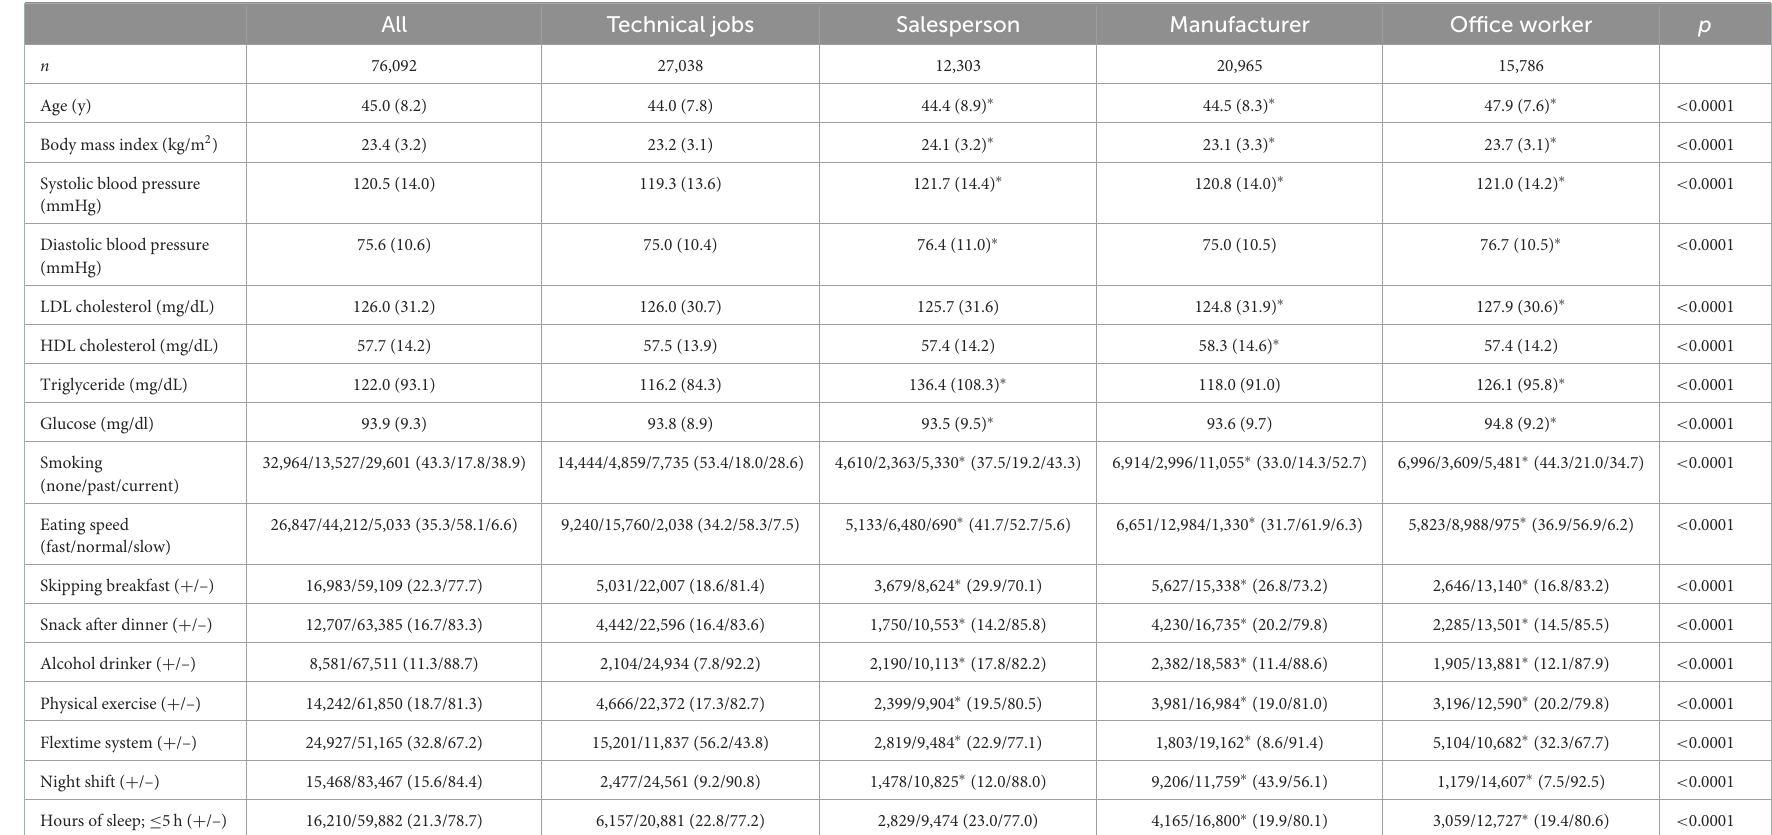
TABLE 1 Characteristics of patients at baseline according to occupation type in men.